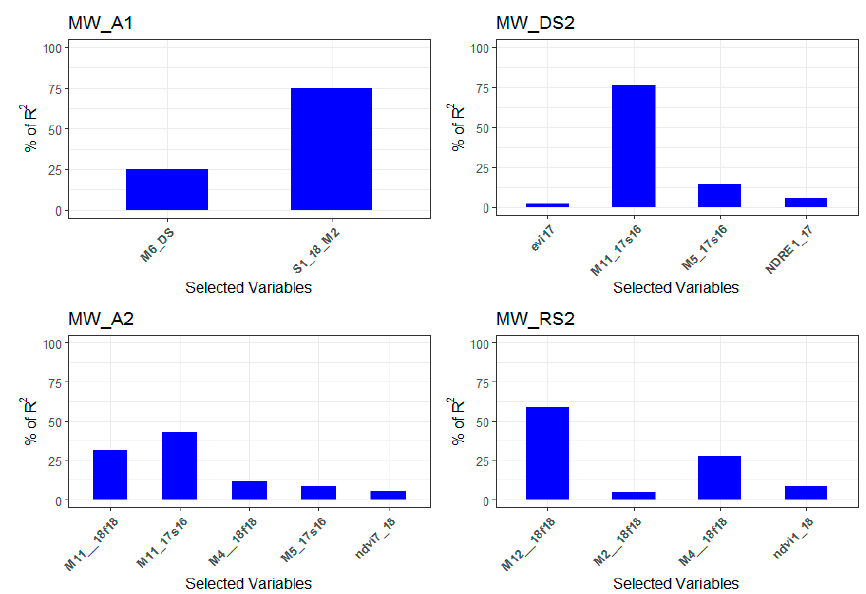
Figure 4. Variable importance for individual predictor variables extracted using MW based methods.